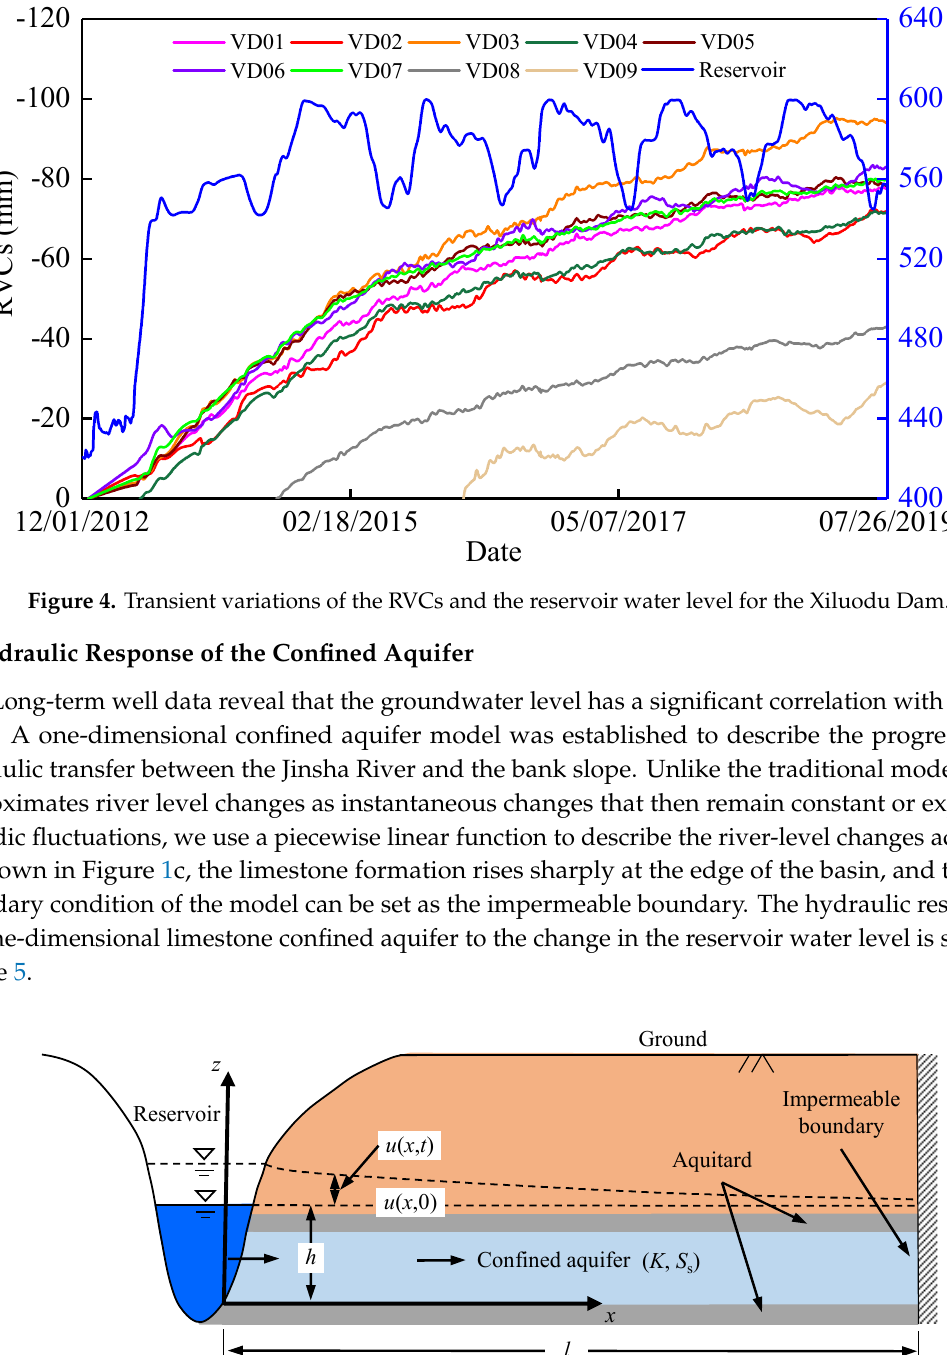
Figure 3. Locations of the monitoring lines of the river valley contractions (RVCs) at the Xiluodu Dam.